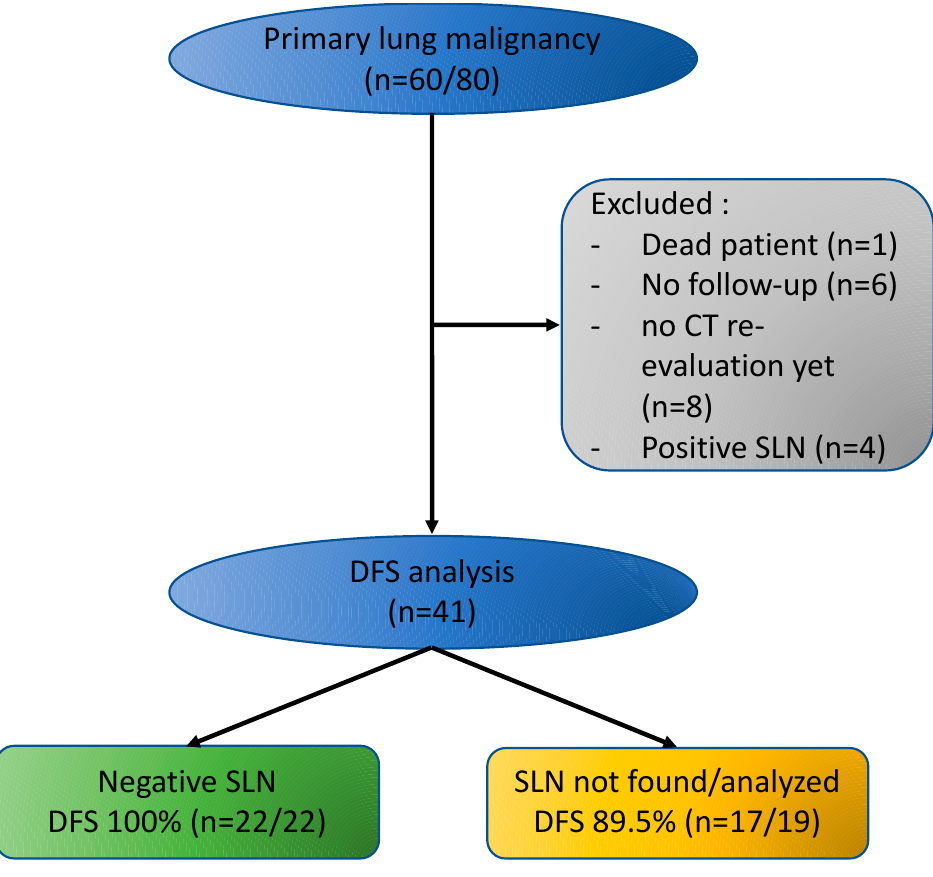
Figure 2. Disease-Free Survival at 5 and 10 months according to SLN pathological status. SLN, Sentinel Lymph Node; DFS, Disease-Free Survival.